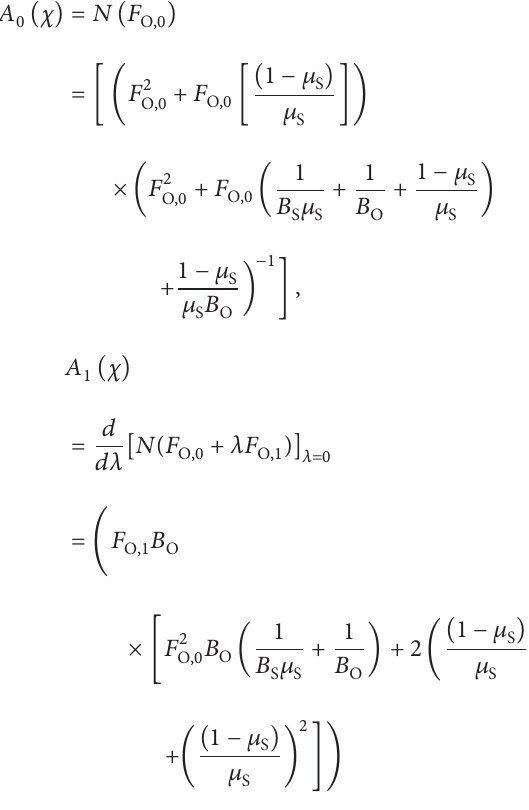
= 50 ( 𝑑 = 55.71 𝜇 M) (ii) 𝜙 2 using (18). (i) 𝜙 2 O O = 400 ( 𝑑 = 158.00 𝜇 O